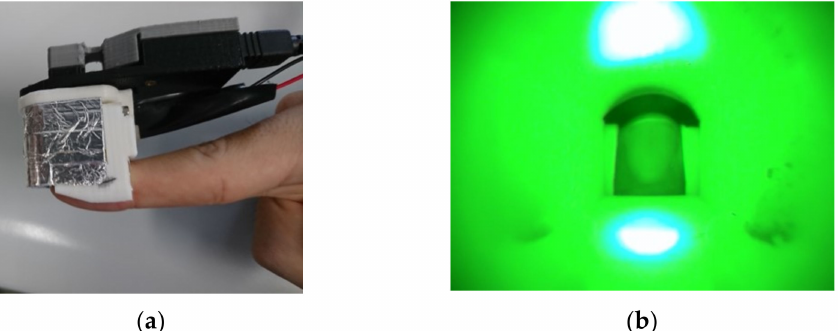
Figure 1. Prototype of the fingernail color sensor: ( a ) appearance of the fingernail color sensor and ( b ) image captured by CMOS camera installed in the